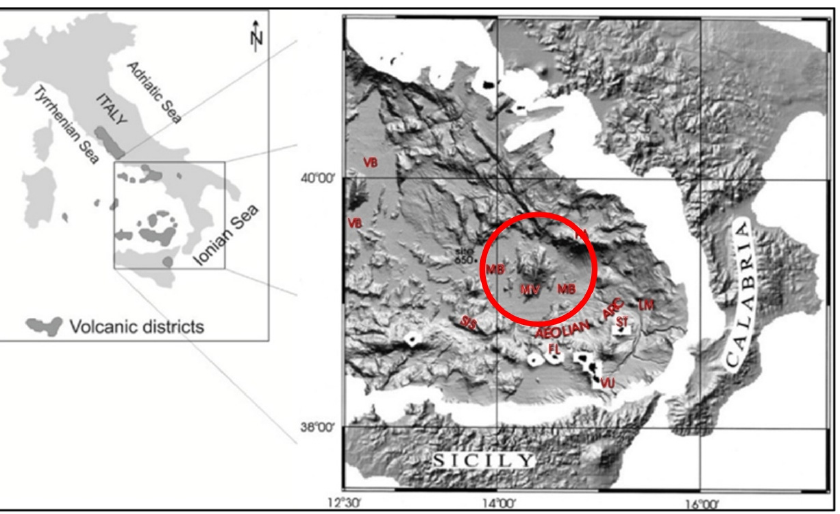
Figure 1. Location of the study area: MV: Marsili volcano and MB: Marsili basin, both indicated with a red circle; ST: Stromboli; VU: Vulcano; FL: Filicudi; SIS: Sisifo submarine volcano; LM: Lametini seamount; PA: Palinuro seamount; VB: Vavilov basin. The map on the right is redrawn from [21] .